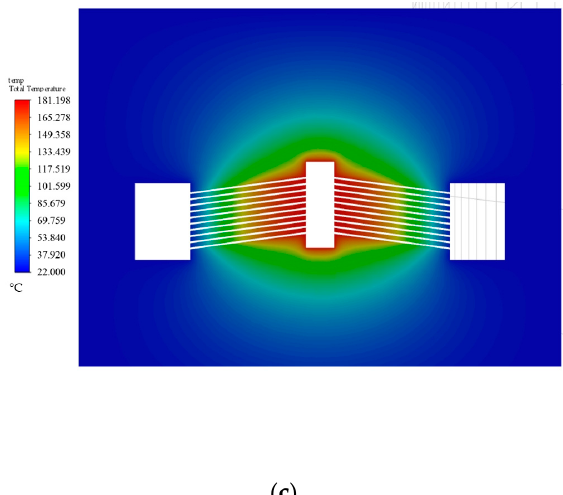
Figure 11. Coupled finite element–finite volume results of the ( a ) temperature distribution within the V-shaped ETA as extracted from the thermal-electric finite element solver (shown in °C), ( b ) displacement of the V-shaped ETA extracted from the structural finite element solver (shown in µm), and ( c ) fluid (air) temperature distribution around the V-shaped ETA extracted from the finite volume solver (shown in °C), all at a 10 V DC input.